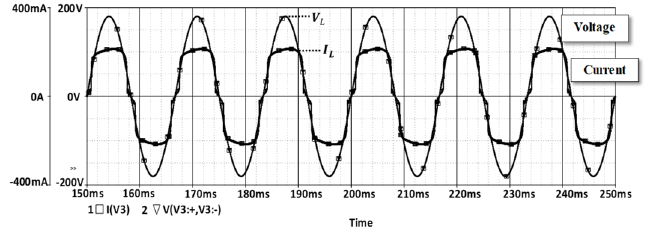
Figure 17. Voltage and current plots of the AC source at the input of the resonant converter simu- lated in SPICE.